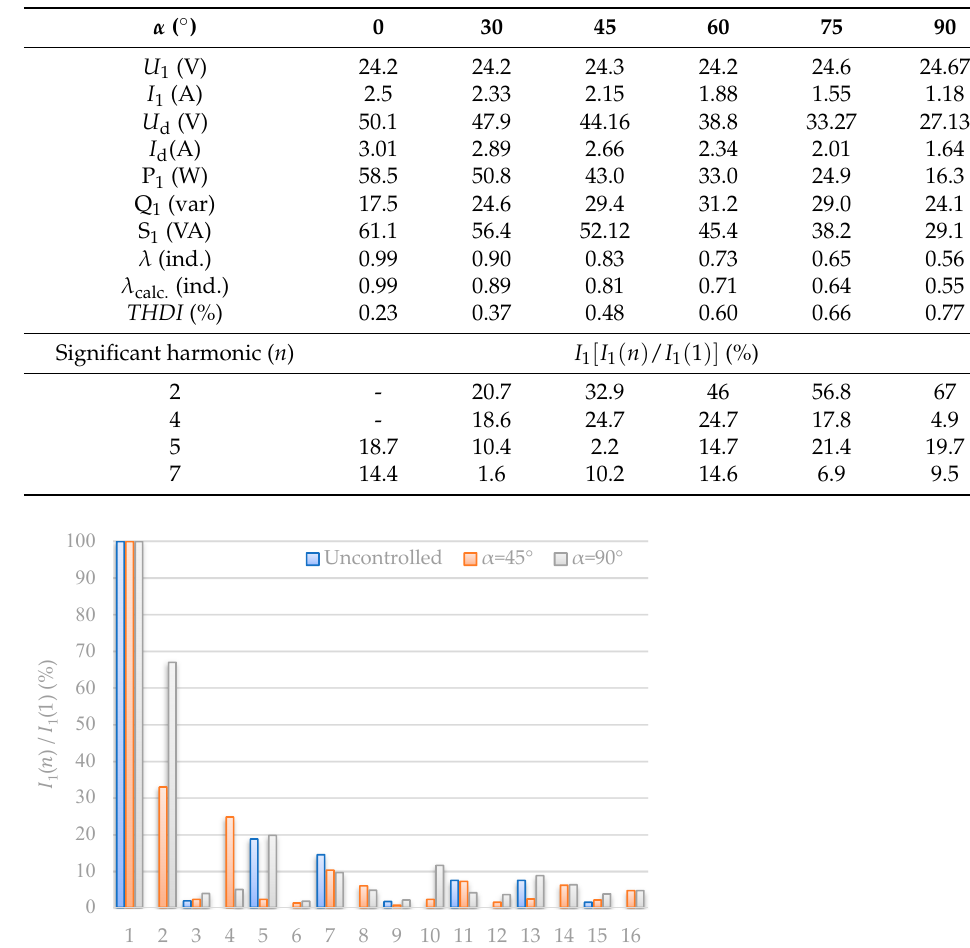
Figure 12. Chart of conducted harmonic analysis of the AC phase current I 1 . After the measurements were made on the uncontrolled rectifier as a reference point, the next step was to do experiments on the semiconverter. The laboratory setup for the semiconverter measurements is shown in Figure 13a, while the top of the assembled sem- iconverter model is shown in Figure 13b.